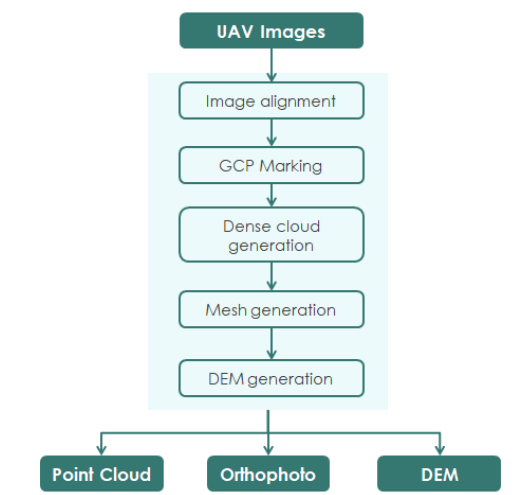
Figure 2. General workflow for the SfM processing